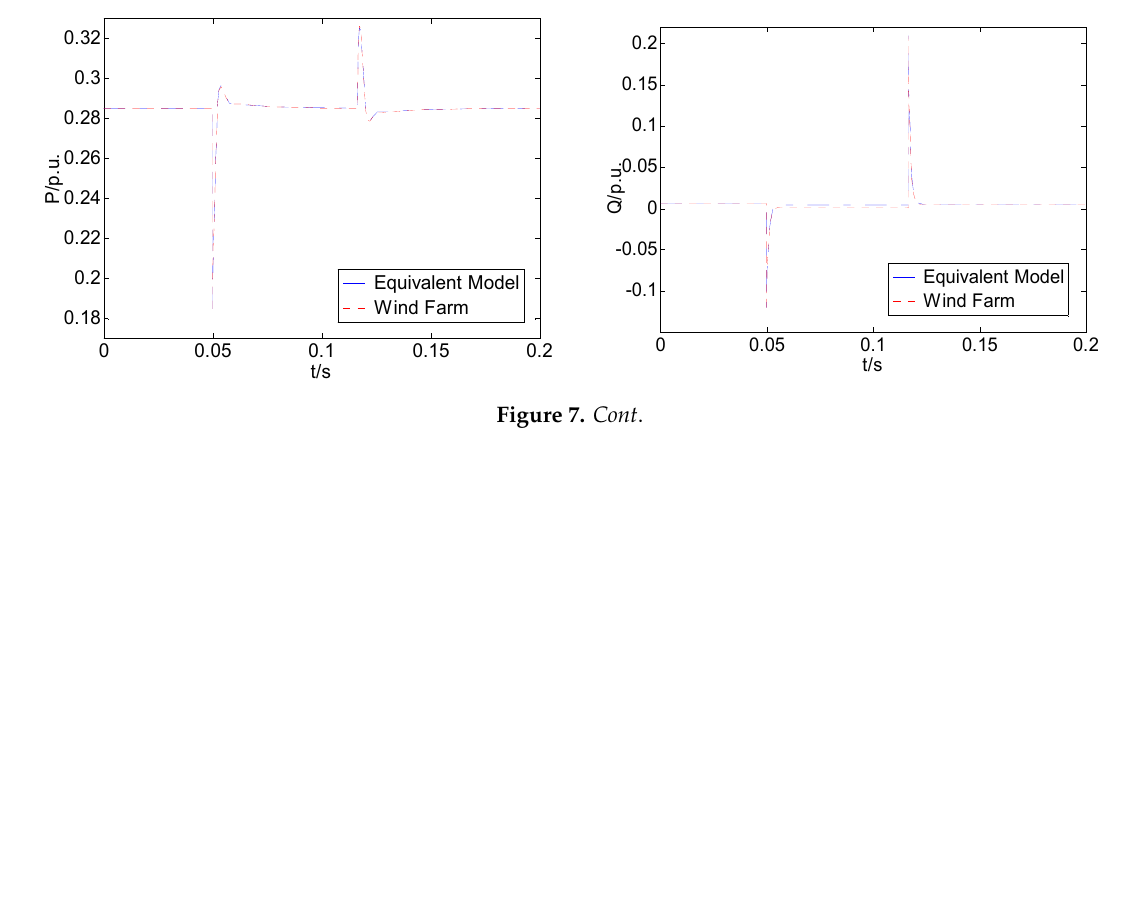
Table 7. Results of parameters estimation 80%